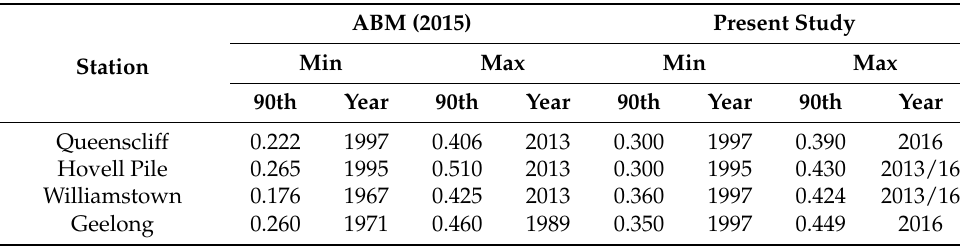
Table 5. Comparisons between the 90th percentile sea levels at several stations in PPB estimated Cardno by for ABM [40] and by the present